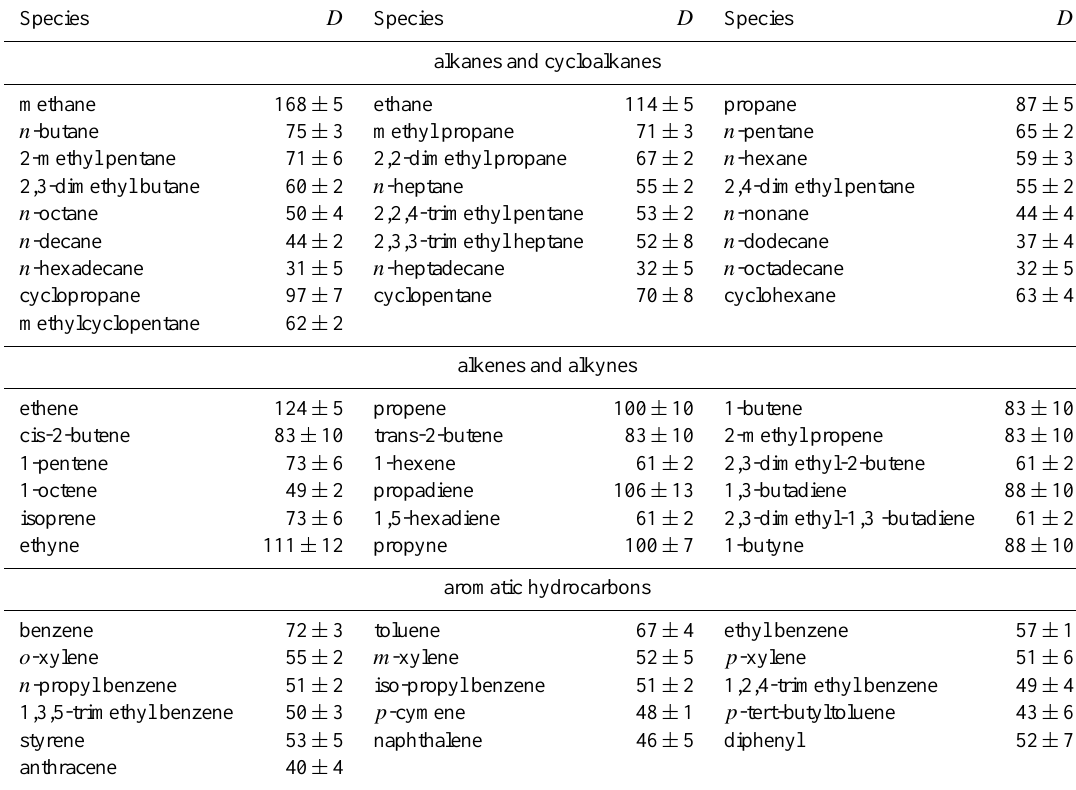
Table 1. Summary of preferred diffusivities ( D , Torrcm 2 s − 1 ) at 298K: alkanes, cycloalkanes, alkenes, alkynes, and aromatic hydrocarbons. The uncertainties given to preferred values are explained in Sect.